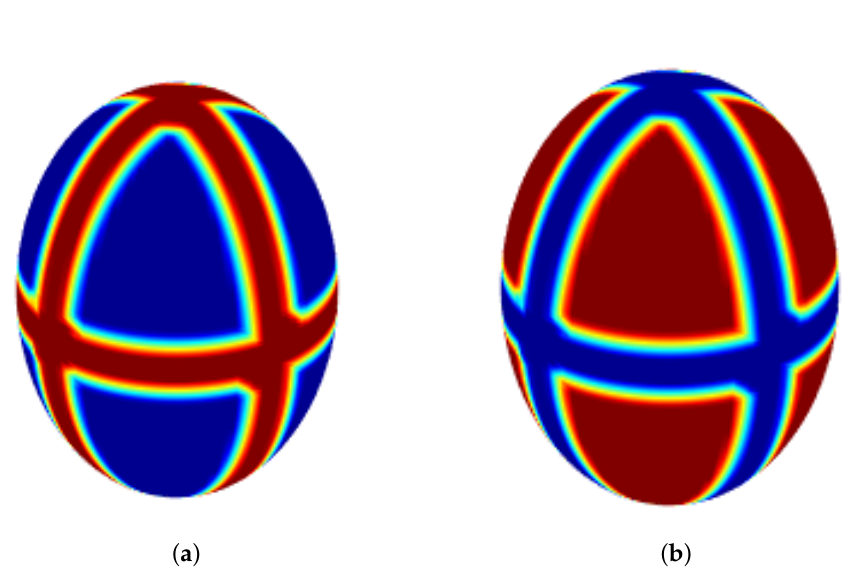
( a ) ( b ) Figure 10. The plot of approximate solution of u ( a ) and the plot of approximate solution of v ( b ) with , and τ = 0.5 dx 2 . TPS for Example 4 by taking dx = 1 8 Table 7. Error estimates and CPU times of Example 3 by letting τ = 0.5 ( dx ) 2 for different values of dx , and stencil size n s .